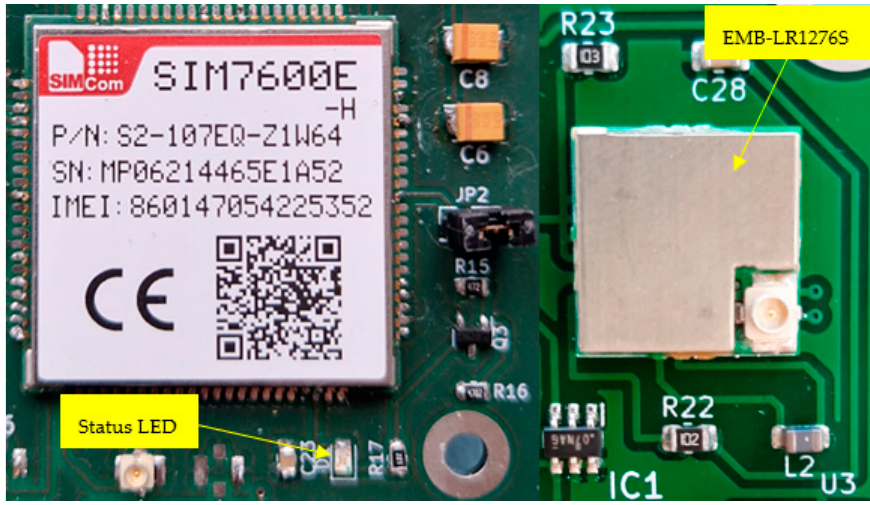
Figure 2. The SIM7600E-H ( left ) and the EMB-LR1276S ( right ). The SIM7600E-H allows information exchange via different telecommunication net- works, including LTE (Long-Term Evolution). All functionalities of the module are available through 87 pads, which are located on the perimeter of the 30 × 30 × 2.9 mm module. There are 4 dedicated pads for voltage input (but only 2 need to be used) and several pads for ground. The module’s supply voltage is between 3.4 and 4.2 V, where 3.8 V is recom- mended. The power supply must be able to provide more than 2 A current. Out of the pads, three pads can be used to connect external antennas: main, auxiliary, and GNSS